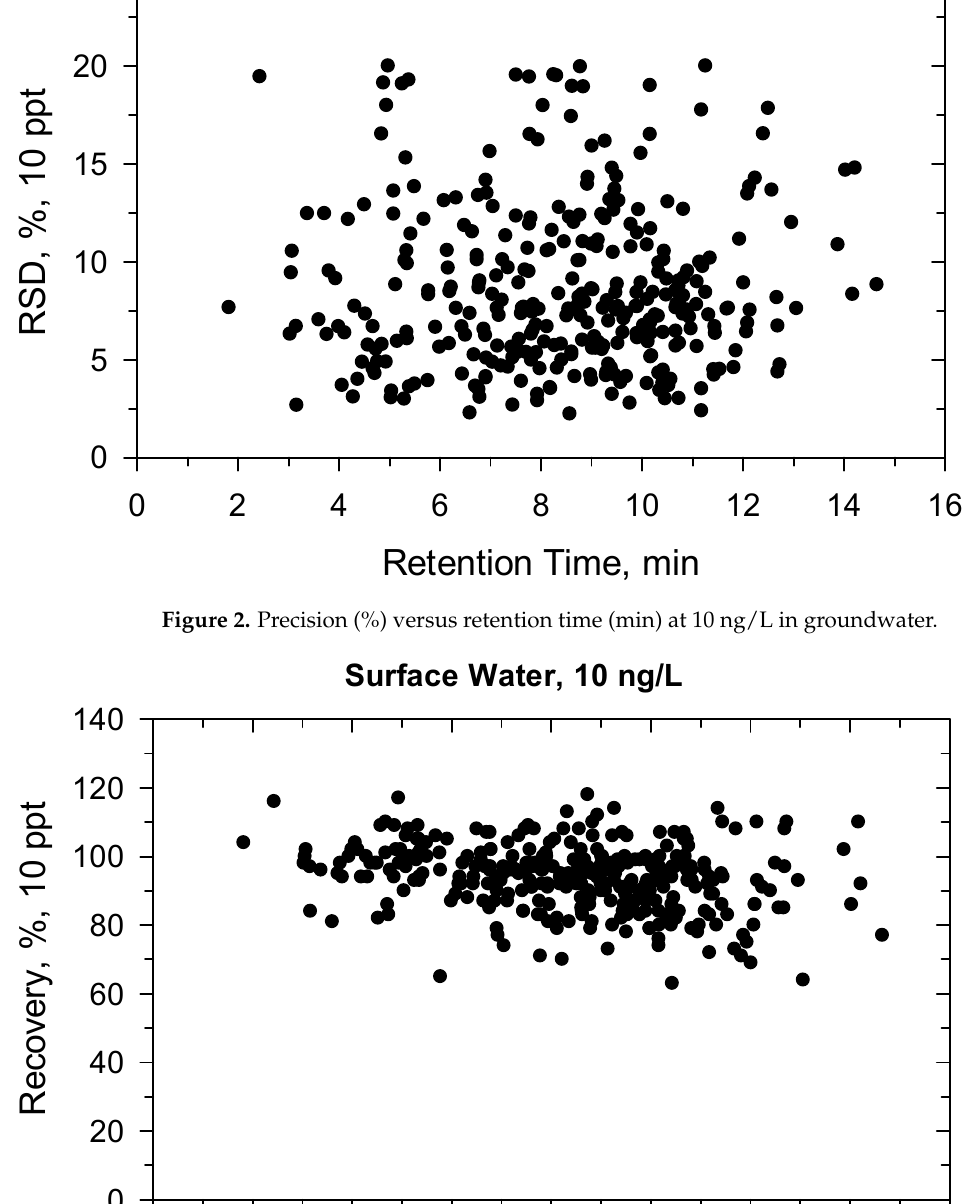
Figure 3. Recovery (%) versus retention time (min) at 10 ng/L in surface water.